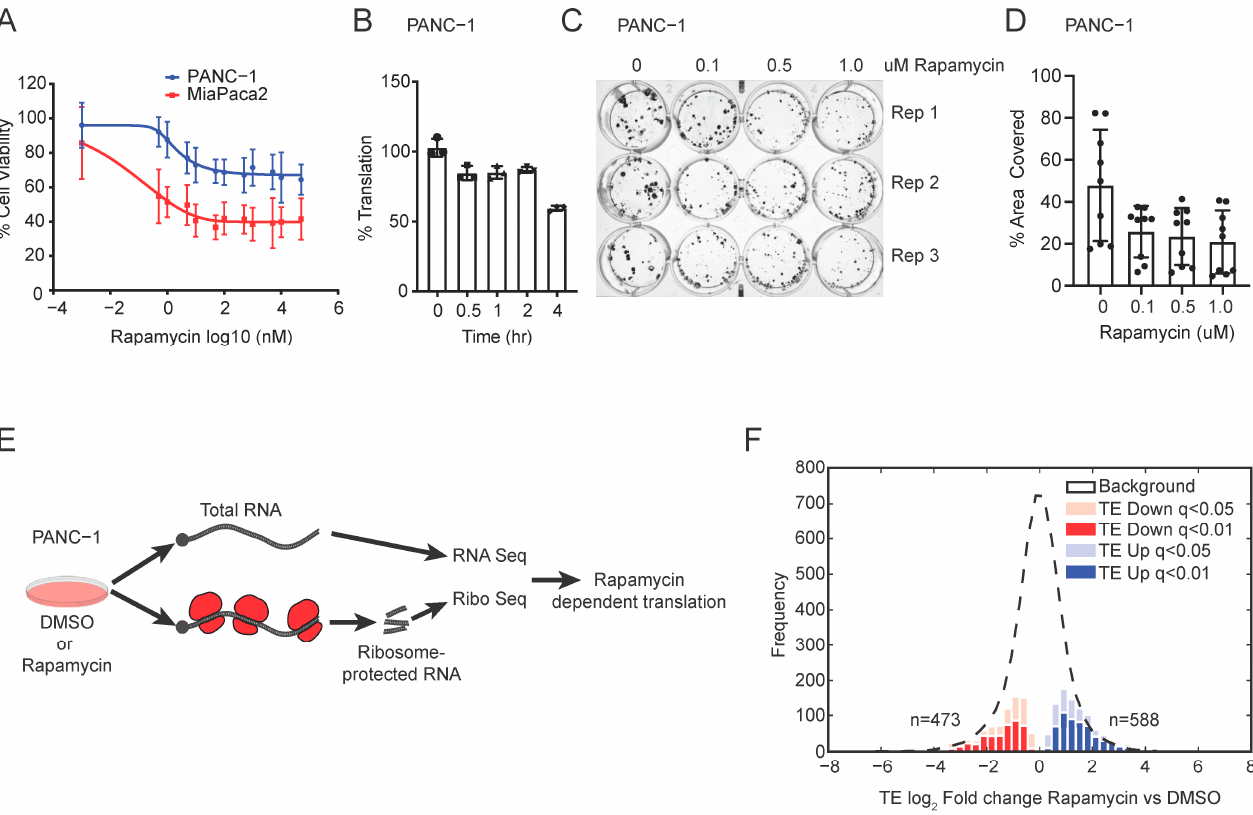
Figure 1. Ribosome footprinting identifies translational targets of mTOR and RPS6. ( A ) Cell viability assay showing the IC50 for rapamycin in PANC-1 and MiaPaca2 cells. ( B ) Global mRNA translation as measured by AHA incorporation in PANC-1 cells. ( C , D ) The clonogenic assay shows that rapamycin treatment inhibits cell growth in PANC-1 cells. ( E ) Schematic showing the experimental design for RNA seq and ribosome footprinting in PANC-1 cells treated with DMSO or rapamycin (50 nM; 1 h). Comparison of ribosome-protected sequences and total mRNA isolates the translational efficiency for each mRNA. ( F ) Frequency distribution of the change in translation efficiency (TE) in DMSO and rapamycin-treated PANC-1 cells. Using the statistical cut-offs of q < 0.01 and q < 0.05, mRNAs with decreased (TE down, red, and pink), increased (TE up, blue, and light blue), and unchanged (background, in dashed line) mRNA transcripts were identified.